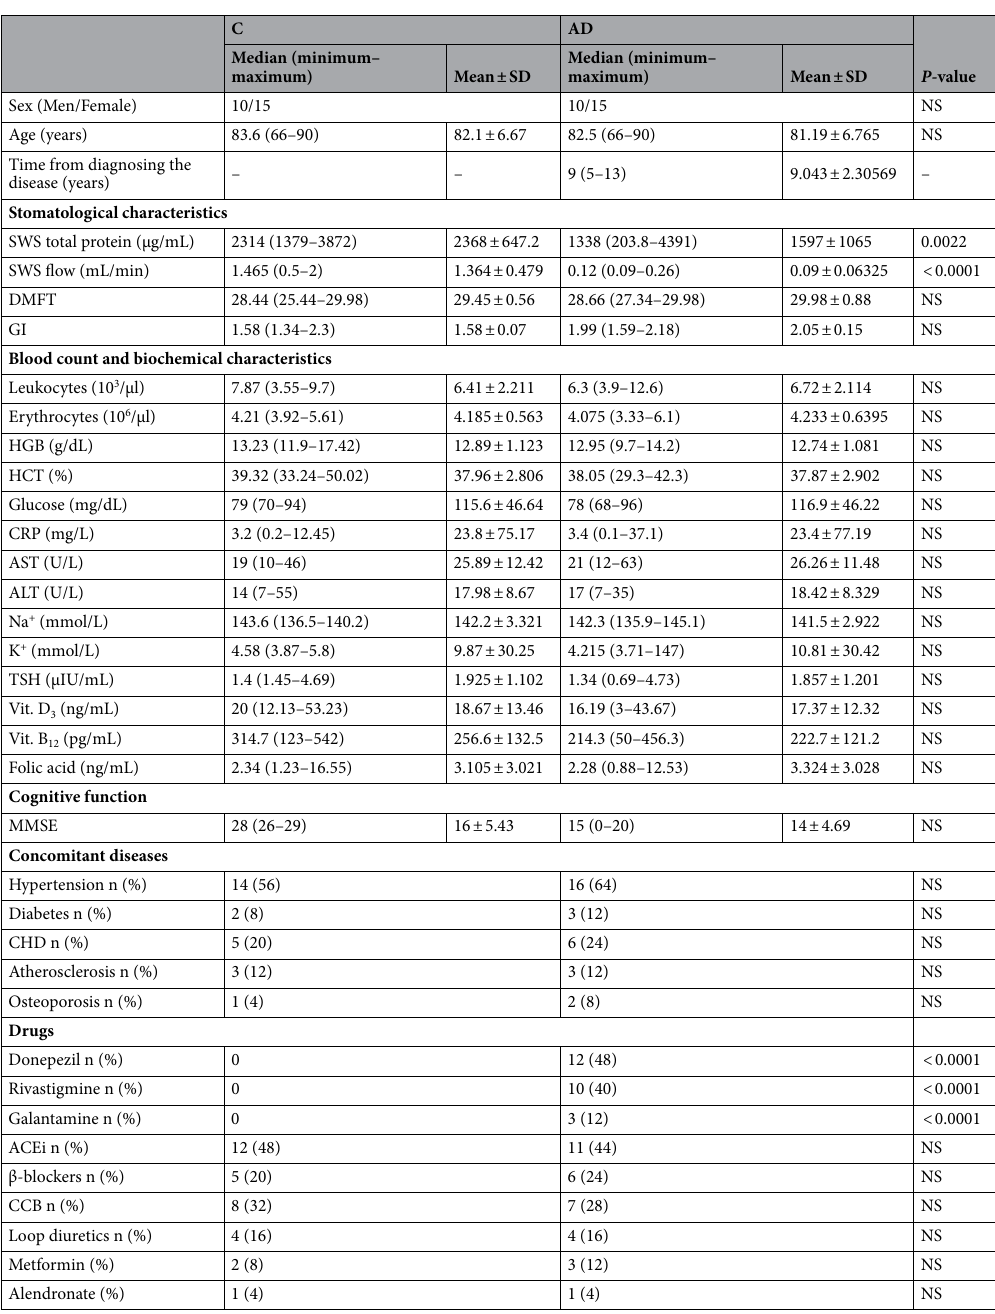
Table 1. Stomatological and clinical characteristics of AD patients and the control group. AD—Alzheimer’s disease; C—control group; SWS—stimulated whole saliva; DMFT—decayed, missing, filled teeth